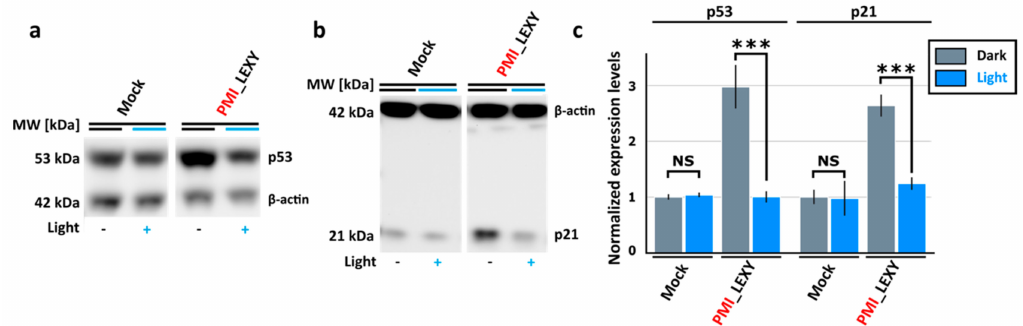
Figure 3. LEXY allows controlling with light endogenous p53 and p21 levels. (a, b) Western blot showing the levels of p53 ( a ) and p21 ( b ) in HCT166 cells. Mock indicates cells transfected with empty pcDNA3.1( + ). β -actin was used as loading control. ( c ). Bar plot showing the quantification of three independent western blots with samples as in (a) and (b). Levels are shown normalized to the levels of the mock, dark control. NS p ≥ 0.05, *** p < 0.001, t